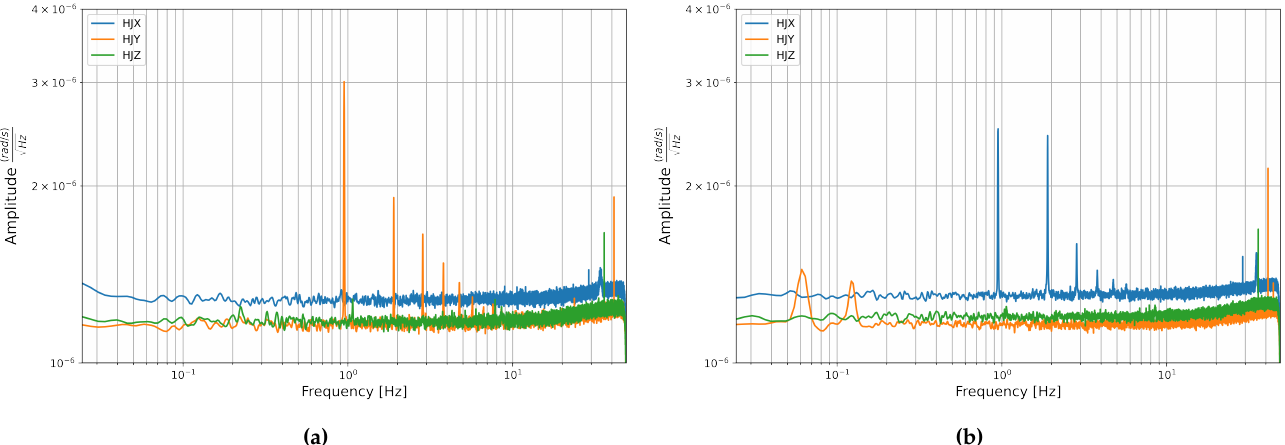
Figure 7. Power Spectral Density of the rotation components from data recorded in the basement test site of the LMU Geophysical Observatory in Fürstenfeldbruck ( a ) Stream 1: from 27 November to 29 November 2019 and ( b ) Stream 2: from 29 November to 2 December 2019.